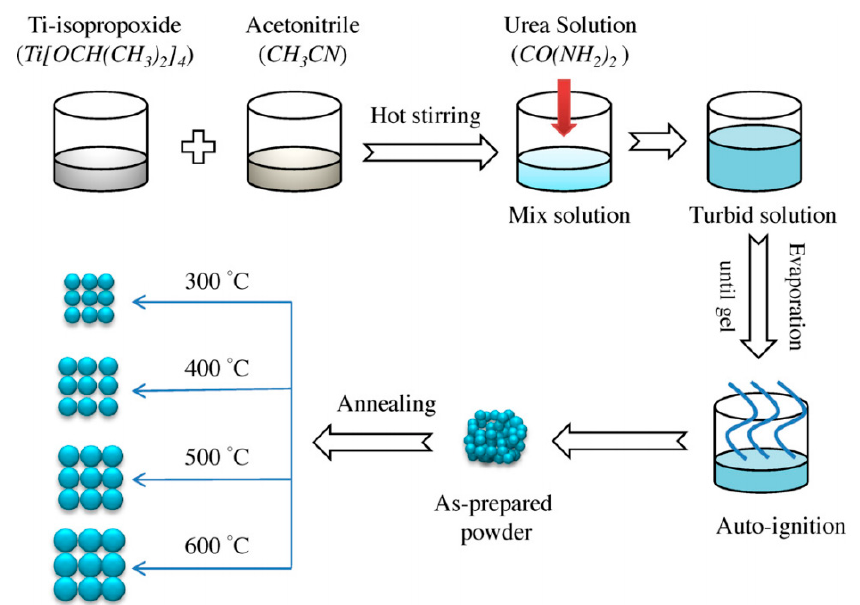
Figure 8 . Simple synthesis and particle size effects of TiO 2 nanoparticle anodes for rechargeable Figure 8. Simple synthesis and particle size e ff ects of TiO 2 nanoparticle anodes for rechargeable lithium lithium ion batteries (Reproduced with the permission from reference [129]) ion batteries (Reproduced with the permission from reference [129]).